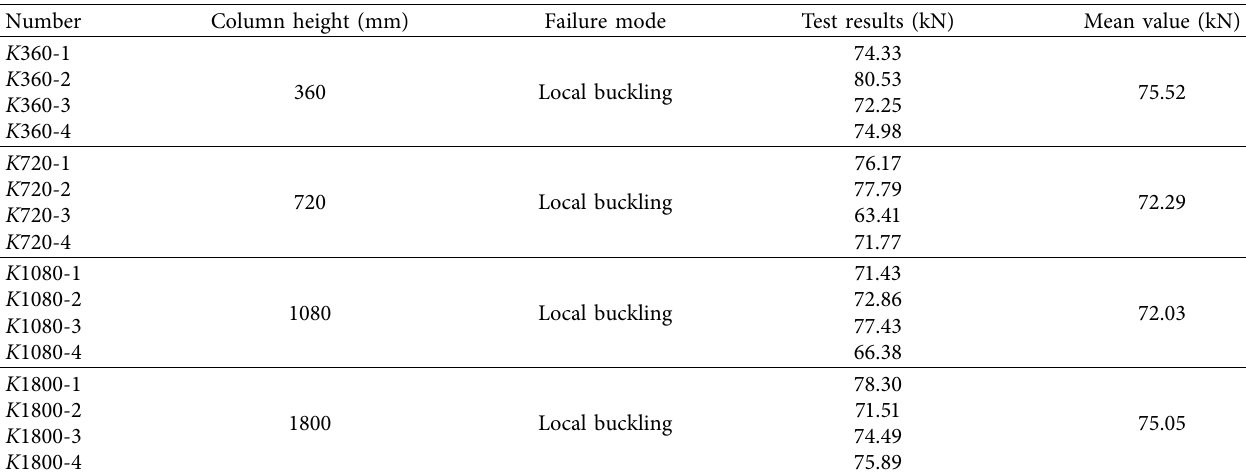
Figure 4: Failure modes. Table 2: Ultimate bearing